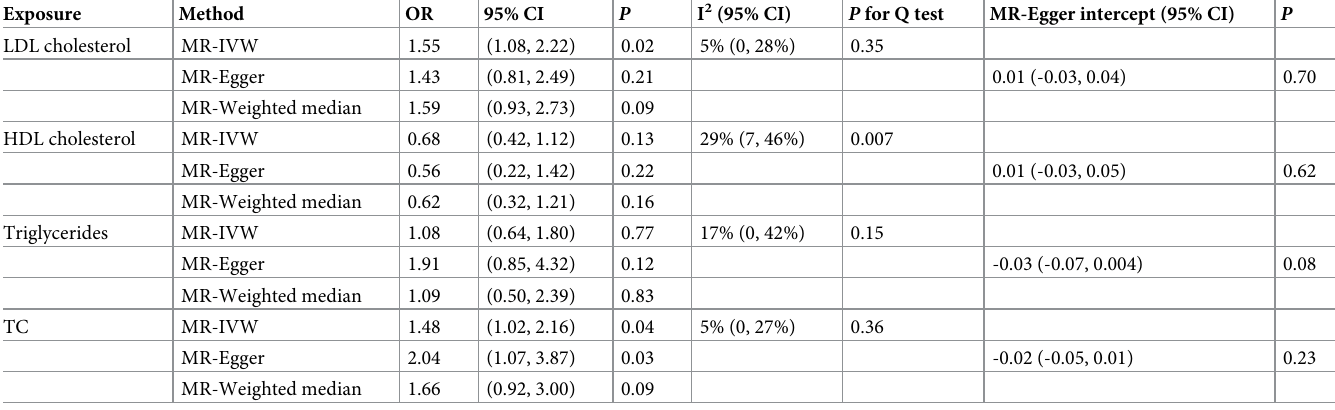
Table 3. (Primary analysis). Two-sample Mendelian randomization results for the odds of AAA per 1 SD increment in lipid fraction measures. SNP—lipid associa- tions are from the GLGC and SNP—AAA associations (adjusted for age, sex, and center) are from ARIC.